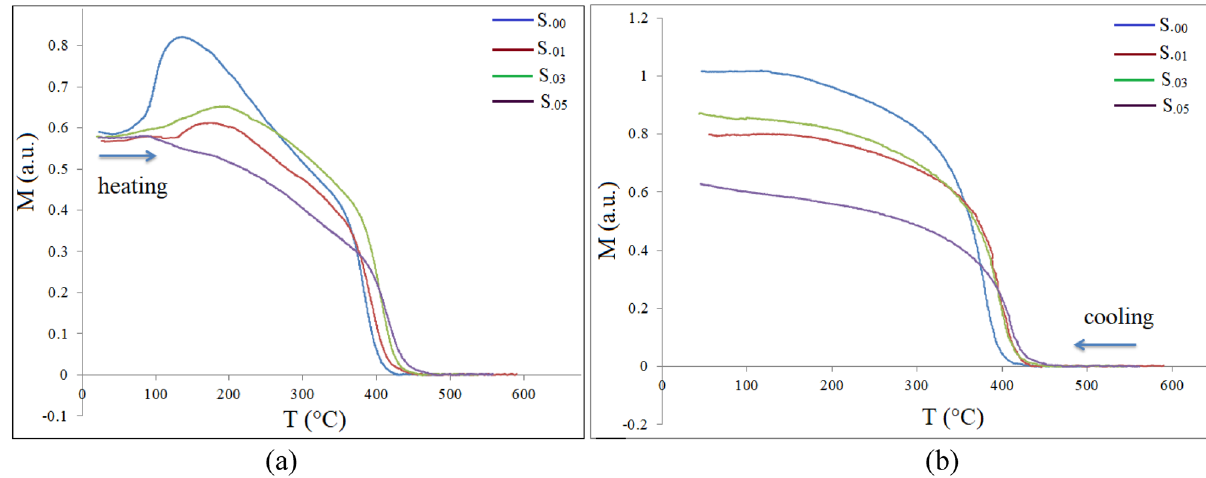
Figure 9. M-T curves of the samples, in heating ( a ) and in cooling ( b )